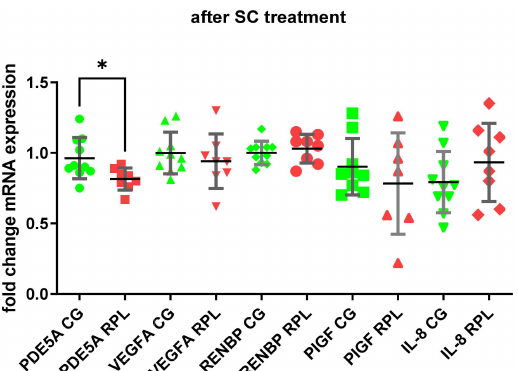
Figure 1. PDE5A , VEGF-A, ANG-I, PIGF, IL-8 expression after SC treatment in the idNK cells of healthy and RPL women, data shown as the mean ± SD compared with idNK cells maintained without SC (green points, CG—control group, n = 10; red points—RPL patients, n = 8; statistical significance * p < 0.05).